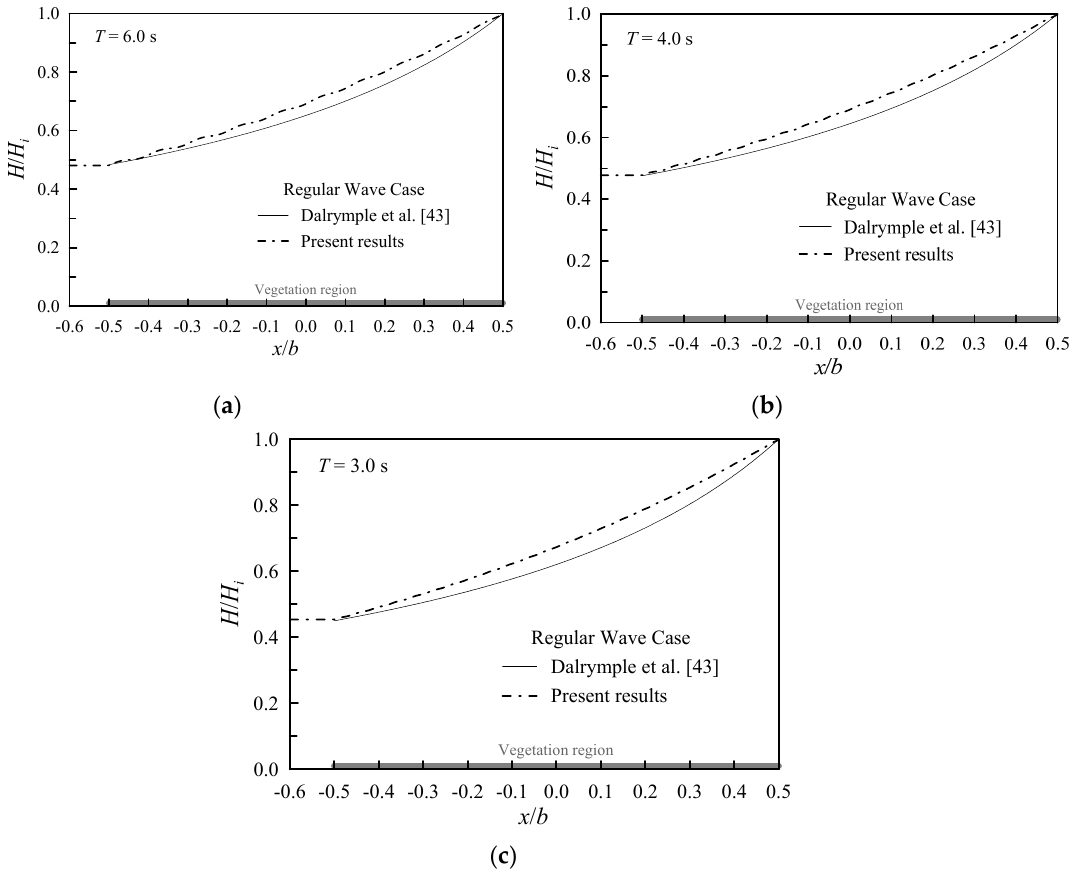
Figure 5. Comparison of H / H i evolution in the vegetation region for the present analytical solution and regular wave transformation model of Dalrymple et al. [43] ( H i = 0.2 m, d = 3 m, b = 150 m, b v = 1 m, N v = 1 steam / m 2 , C D = 1, S = 1, µ = 0.333, n (cid:48) = 0.999, ρ s = 681.43 kg / m 3 , ρ w = 1000 kg / m 3 , ν = 1.12 × 10 − 6 m 2 / s, β = 4.35 × 10 − 10 m 2 / N, and G = 1.29 × 10 5 N / m 2 ). ( a ) T = 6 s; ( b ) T = 4 s; ( c ) T = 3 s. Table 3. RMSE and COR of K t for the proposed solution (based on the K t values obtained by Dalrymple et al. [43] shown in Figures 4 and 5). Statistical Coe ffi cients Proposed